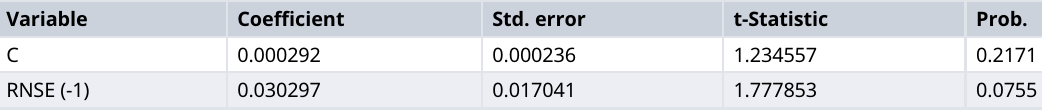
Table 1. The least square coefficients of NSE daily return (dependent variable: RNSE). Variable Coefficient Std. error t-Statistic Prob. C 0.000292 0.000236